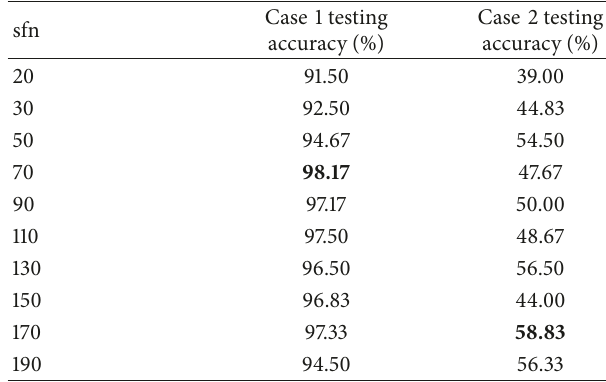
Table 21: Bearing fault diagnosis results obtained by the OFS- FSASD-NPE-SVM (dimension size is